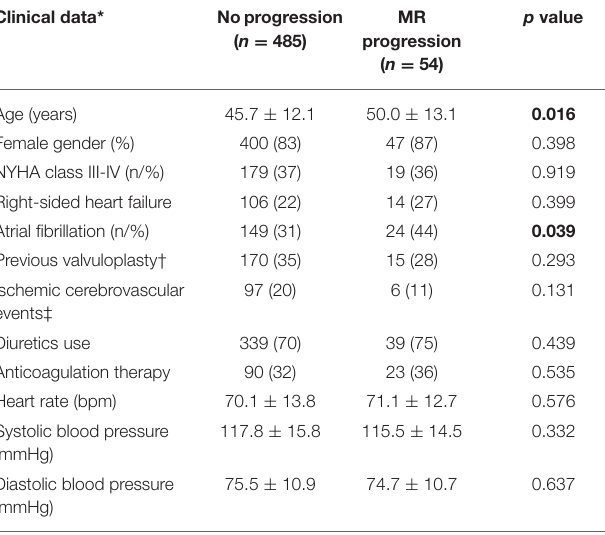
TABLE 1 | Demographic and clinical characteristics of the study population stratified by mitral regurgitation (MR) progression. Clinical data*